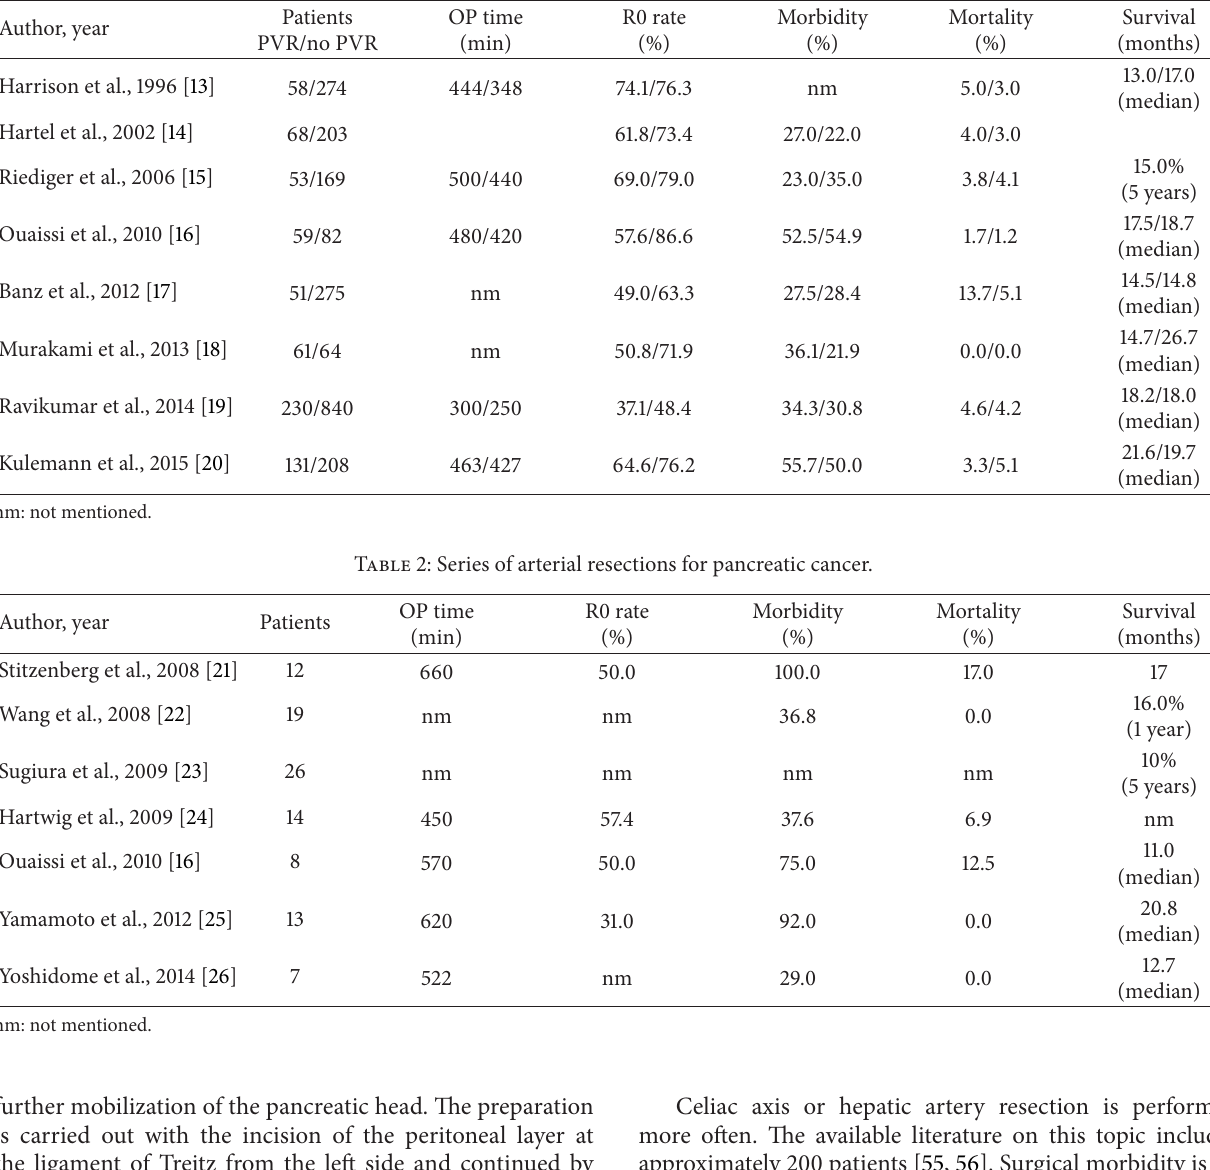
Table 1: Series with > 50 patients comparing resection for pancreatic cancer with and without mesentericoportal vein resections 1995–2015.